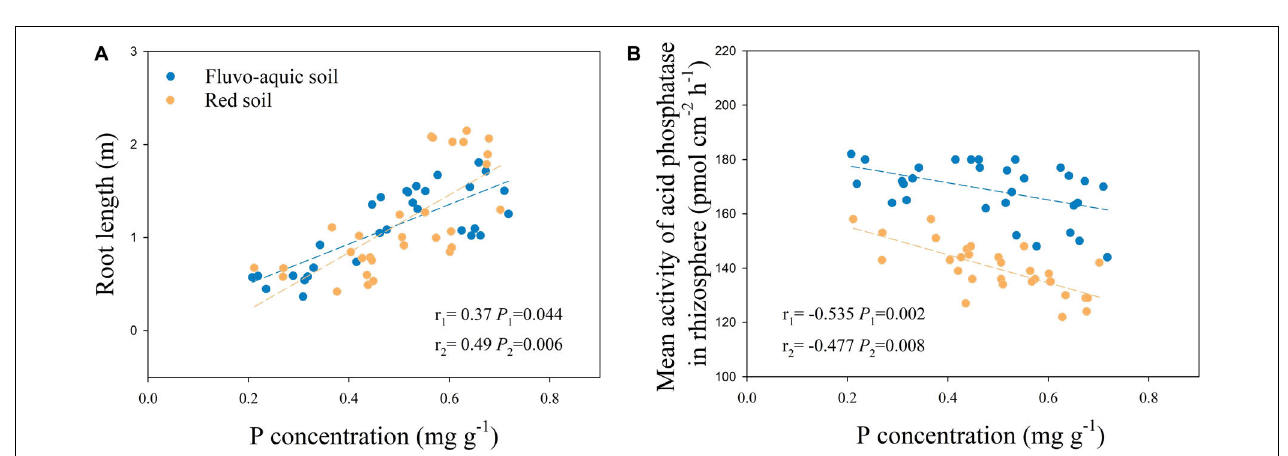
FIGURE 4 | Correlation between root length and root P concentration in P-rich patches and contrast areas (A) , correlation between mean activity of acid phosphatase in rhizosphere and P concentration in P-rich patches and contrast areas (B) . r 1 : Correlation coefficient in fluvo-aquic soil, r 2 : Correlation coefficient in red